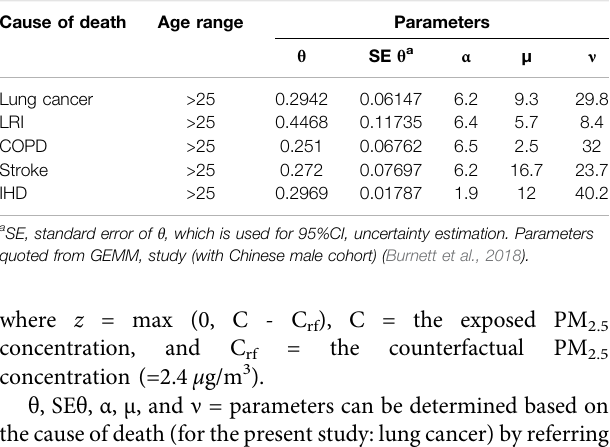
TABLE 3 | Values for the parameter used in the GEMM. Cause of